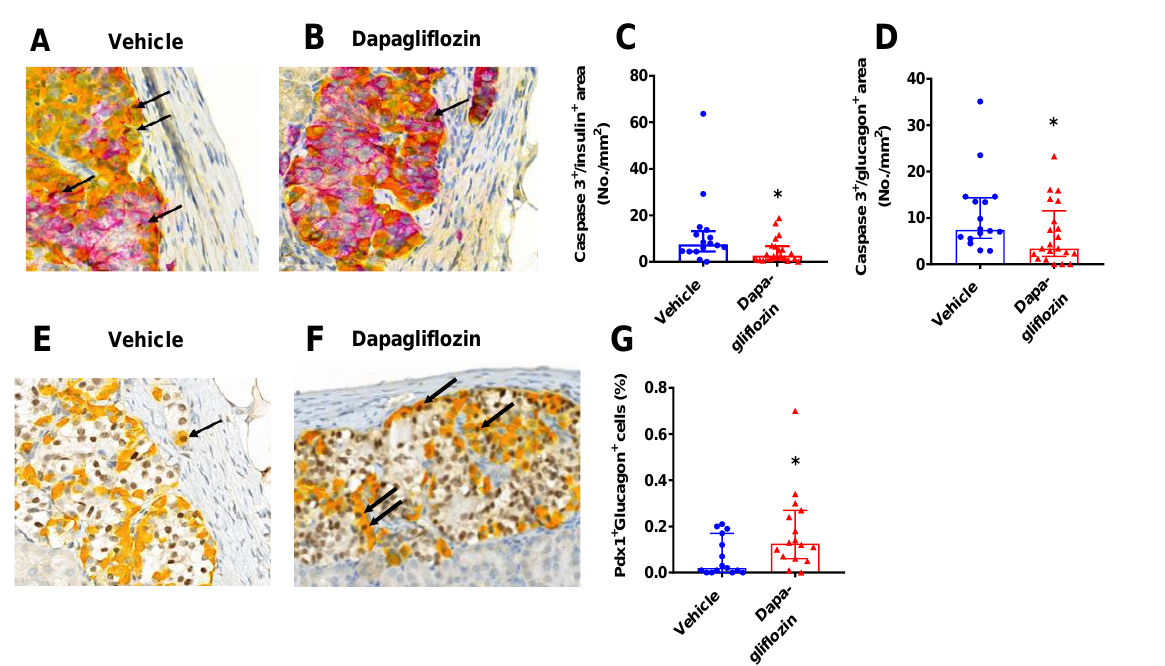
Figure 5. Dapagliflozin reduced alpha and beta cell apoptosis. Triple staining of the human islets grafts with insulin (purple), glucagon (yellow), and caspase 3 (brown) in ( A ) vehicle or ( B ) dapagliflozin-treated mice. The arrows indicate dual Ki67 + and insulin + or glucagon + cells. A computerized method was used to count the number of apoptotic ( C ) insulin + cells and ( D ) glucagon + cells. Dual staining for glucagon (yellow) and PDX-1 (brown) in ( E ) vehicle and ( F ) dapagliflozin-treated mice. ( G ) The percentage of dual PDX-1 and glucagon cells was counted. The data are presented as median with error bars representing the interquartile range. Statistical differences were determined with Mann–Whitney’s non-parametric test. * p < 0.05. Number of samples were n = 21 (dapagliflozin, red symbols), n = 16 (vehicle, blue symbols) for caspase 3 analysis and n = 16 (dapagliflozin, red symbols), n = 15 (vehicle, blue symbols) for PDX1 analysis.